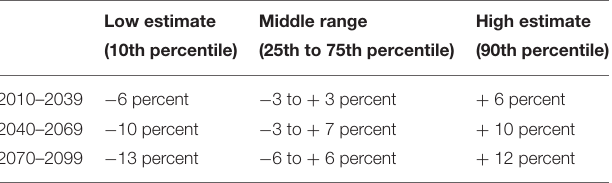
TABLE 5 | Precipitation projections using the UCCRN method for Rio de Janeiro, Brazil, over the 21st century. Low estimate Middle range